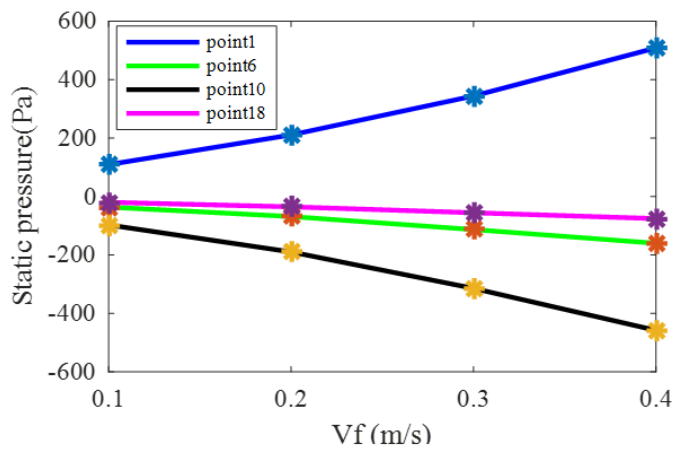
Figure 19. Fitting models.